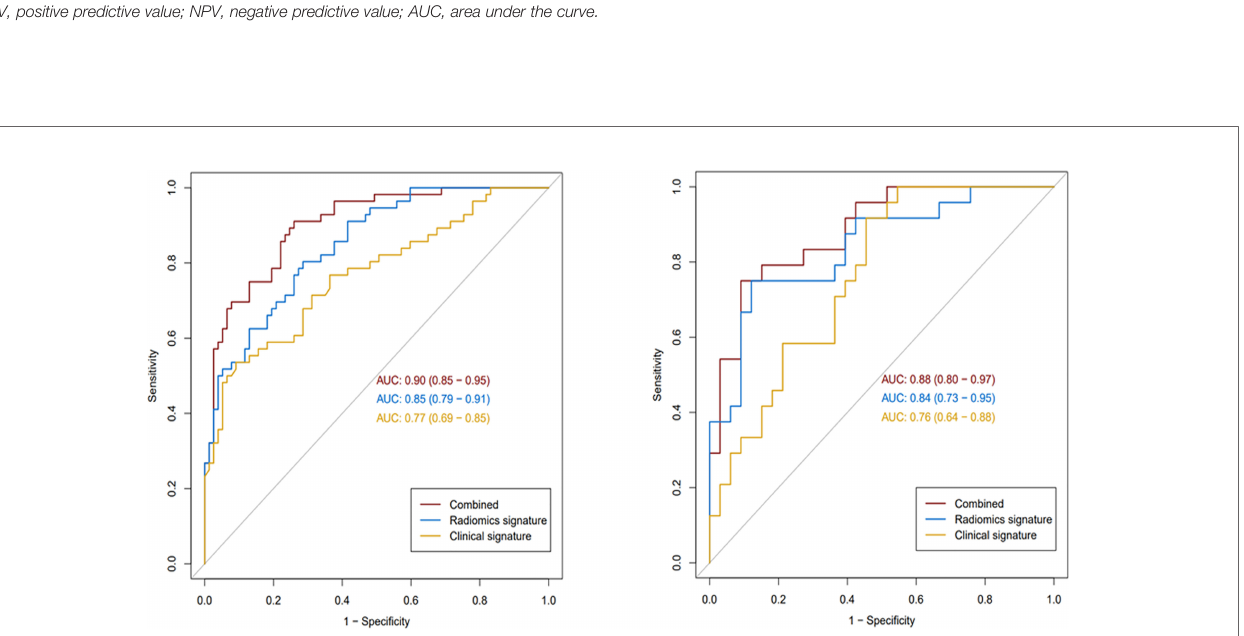
FIGURE 3 | The receiver operating characteristic curves of the three models in the training (left) and validation (right) sets.